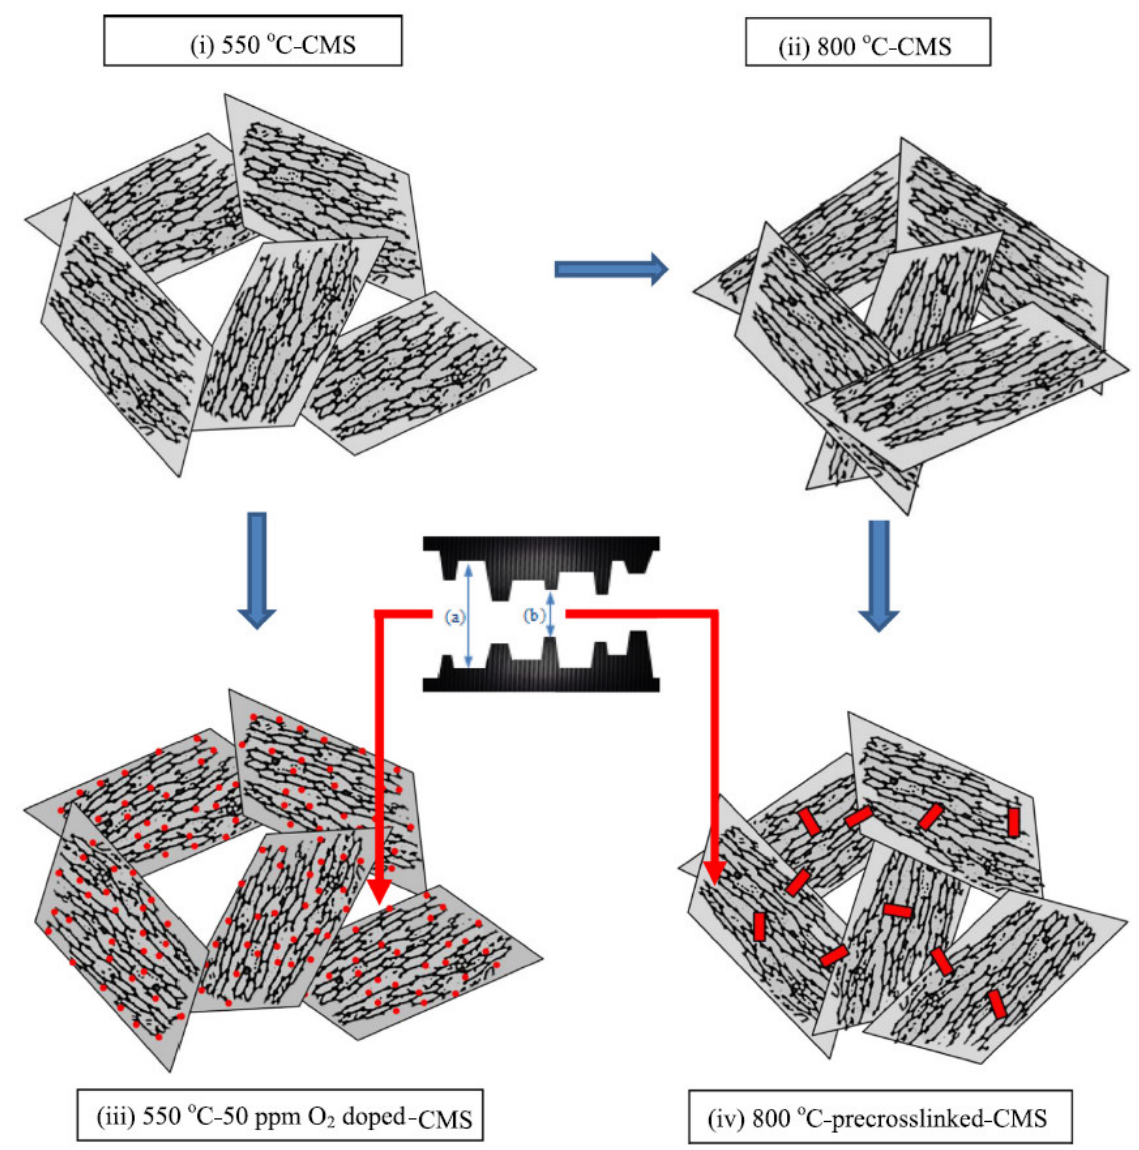
Figure 10. Effects of pyrolysis temperature, O 2 doping, and pre-crosslinking on CMS structures; ( a ) micropores and ( b ) ultramicropores. Adapted from [77] with permission. Copyright (2016) Elsevier.